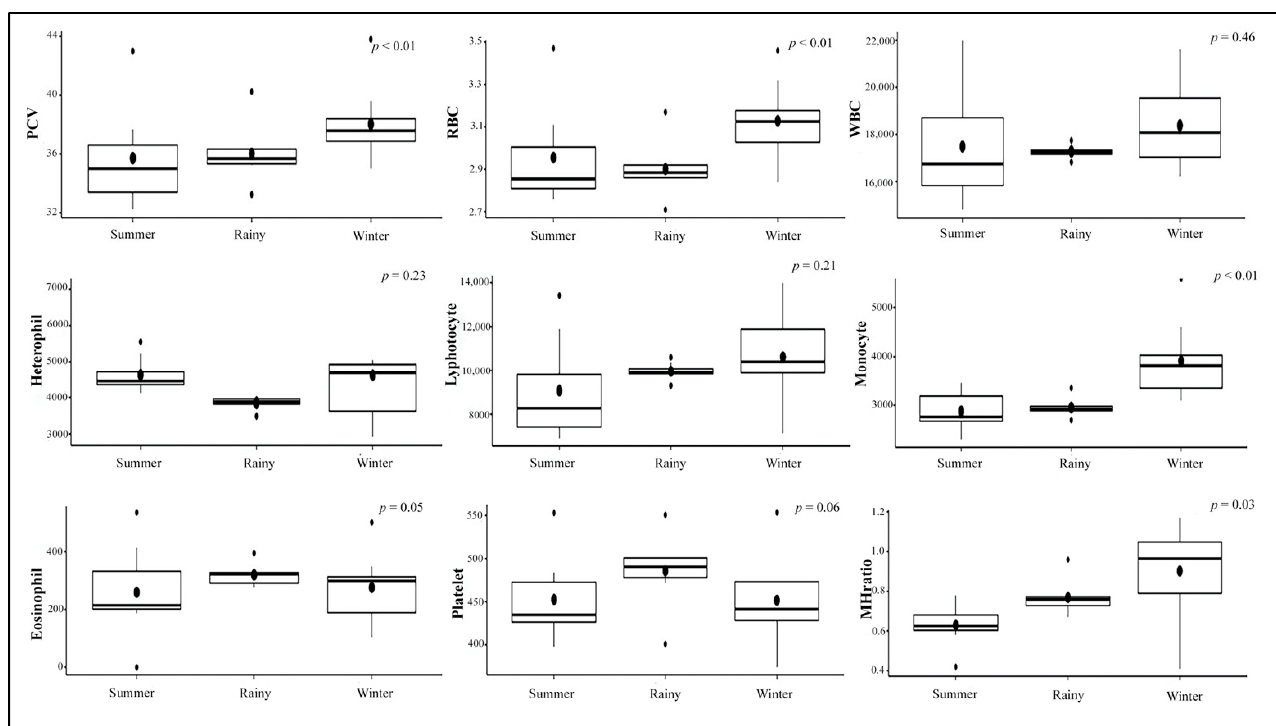
Figure 1. Boxplots of hematology values across three seasons in Thailand, excluding E5 that developed EEHV-HD and died during the study.